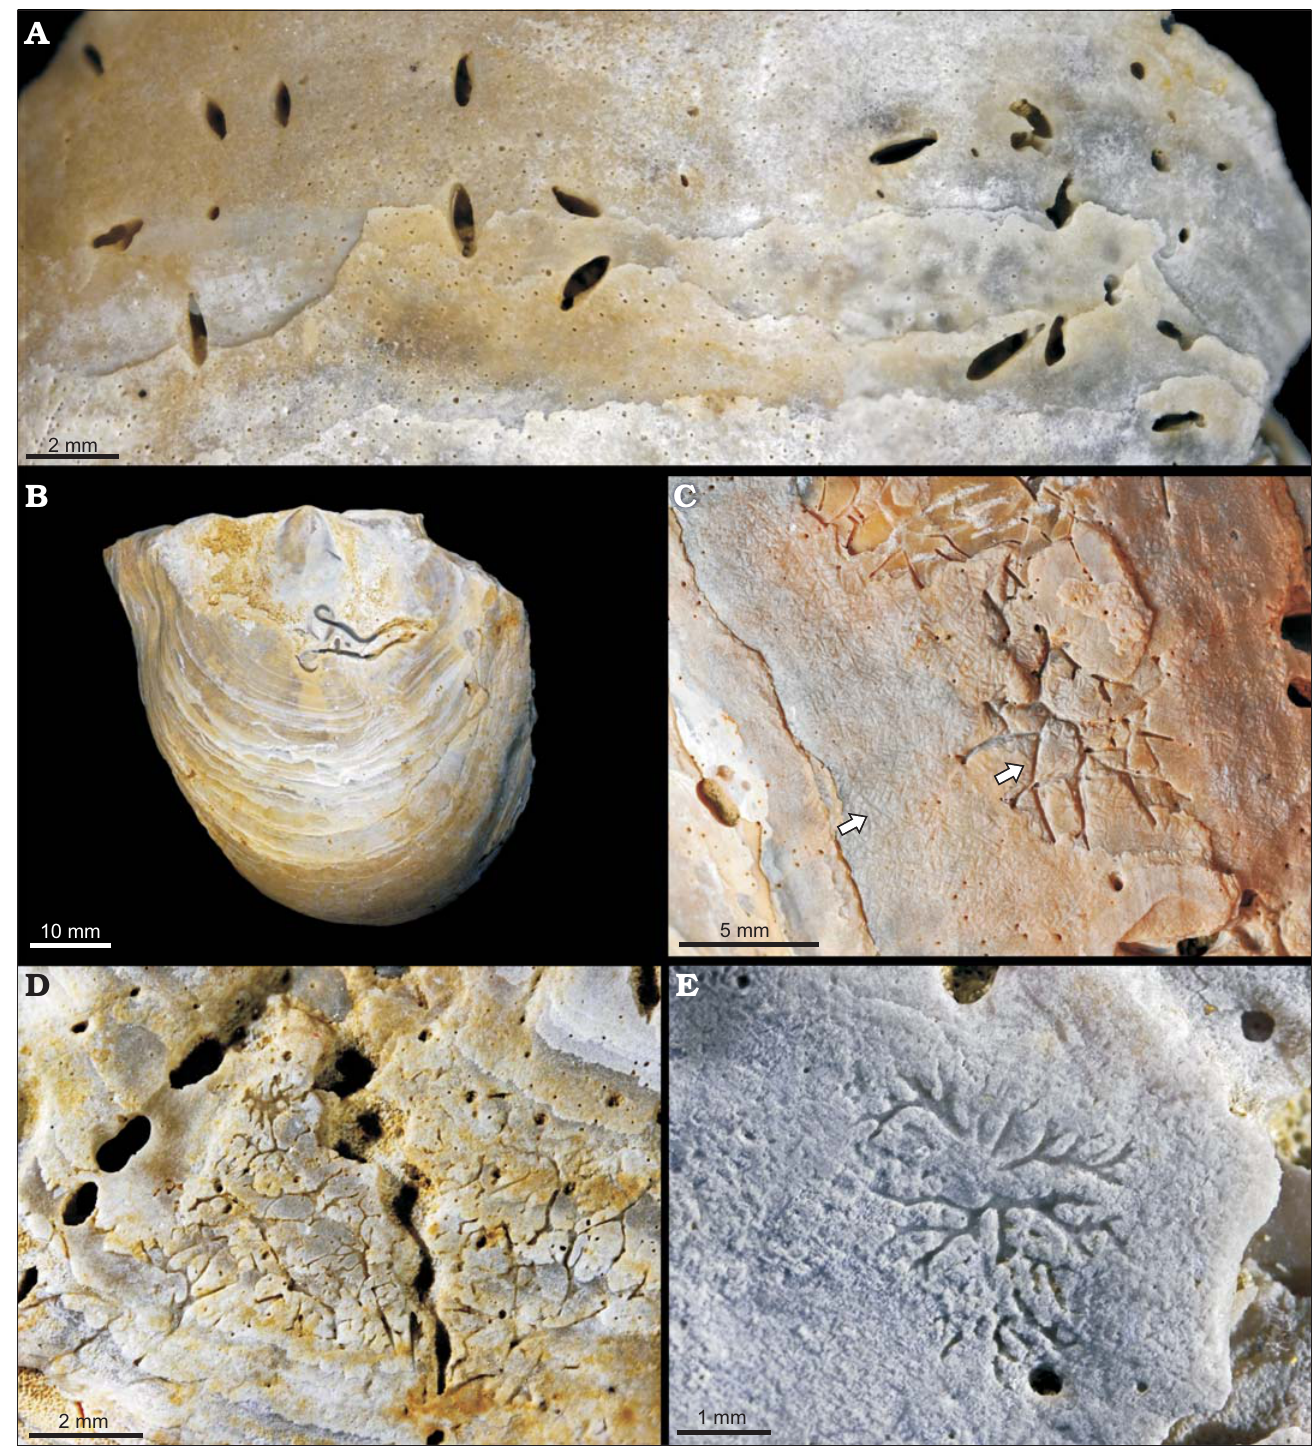
Fig. 3. Traces of borers on oyster Pycnodonte biauriculata (Lamarck, 1819), unless otherwise specified, Marnes à Pycnodonte biauriculata Formation, Upper Ceno manian, Lycée Bellevue earthmoving works, Le Mans, Sarthe Department, France. A . Acrothoracican barnacle traces Rogerella mathieui